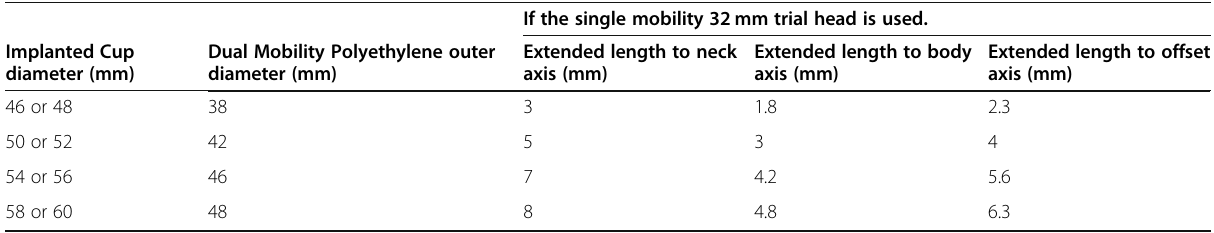
Table 2 The calculation chart showing length along to neck, body, and offset axis using dual mobility system and 32 mm trial head If the single mobility 32 mm trial head is